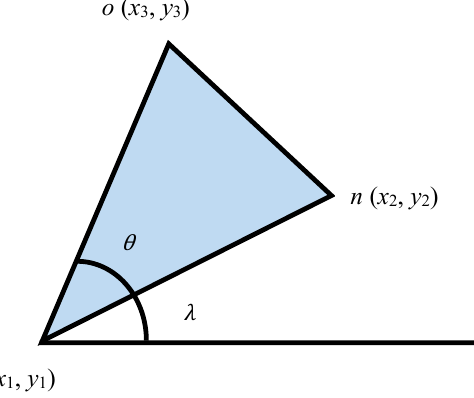
Figure 3. FoV of a camera in a multimedia sensor node.